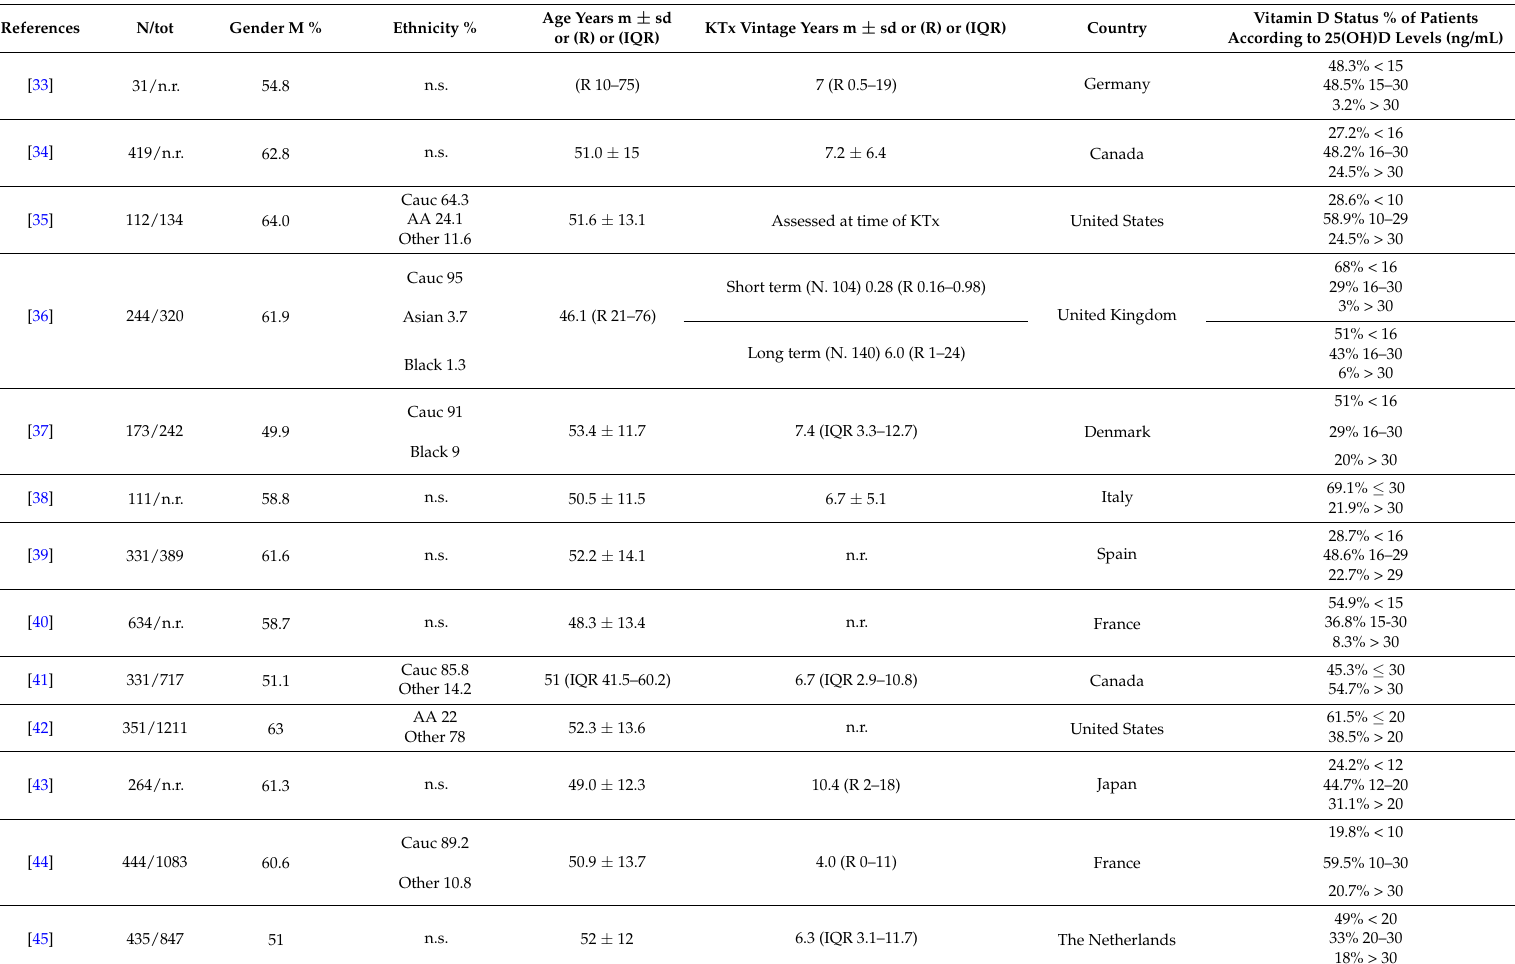
Table 1. Original studies reporting data relative to the native vitamin D status in KTx